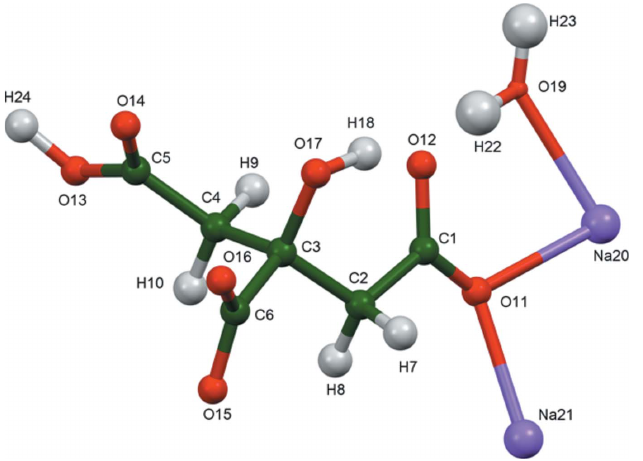
Figure 1 The asymmetric unit of (I) with the atom numbering and 50% probability